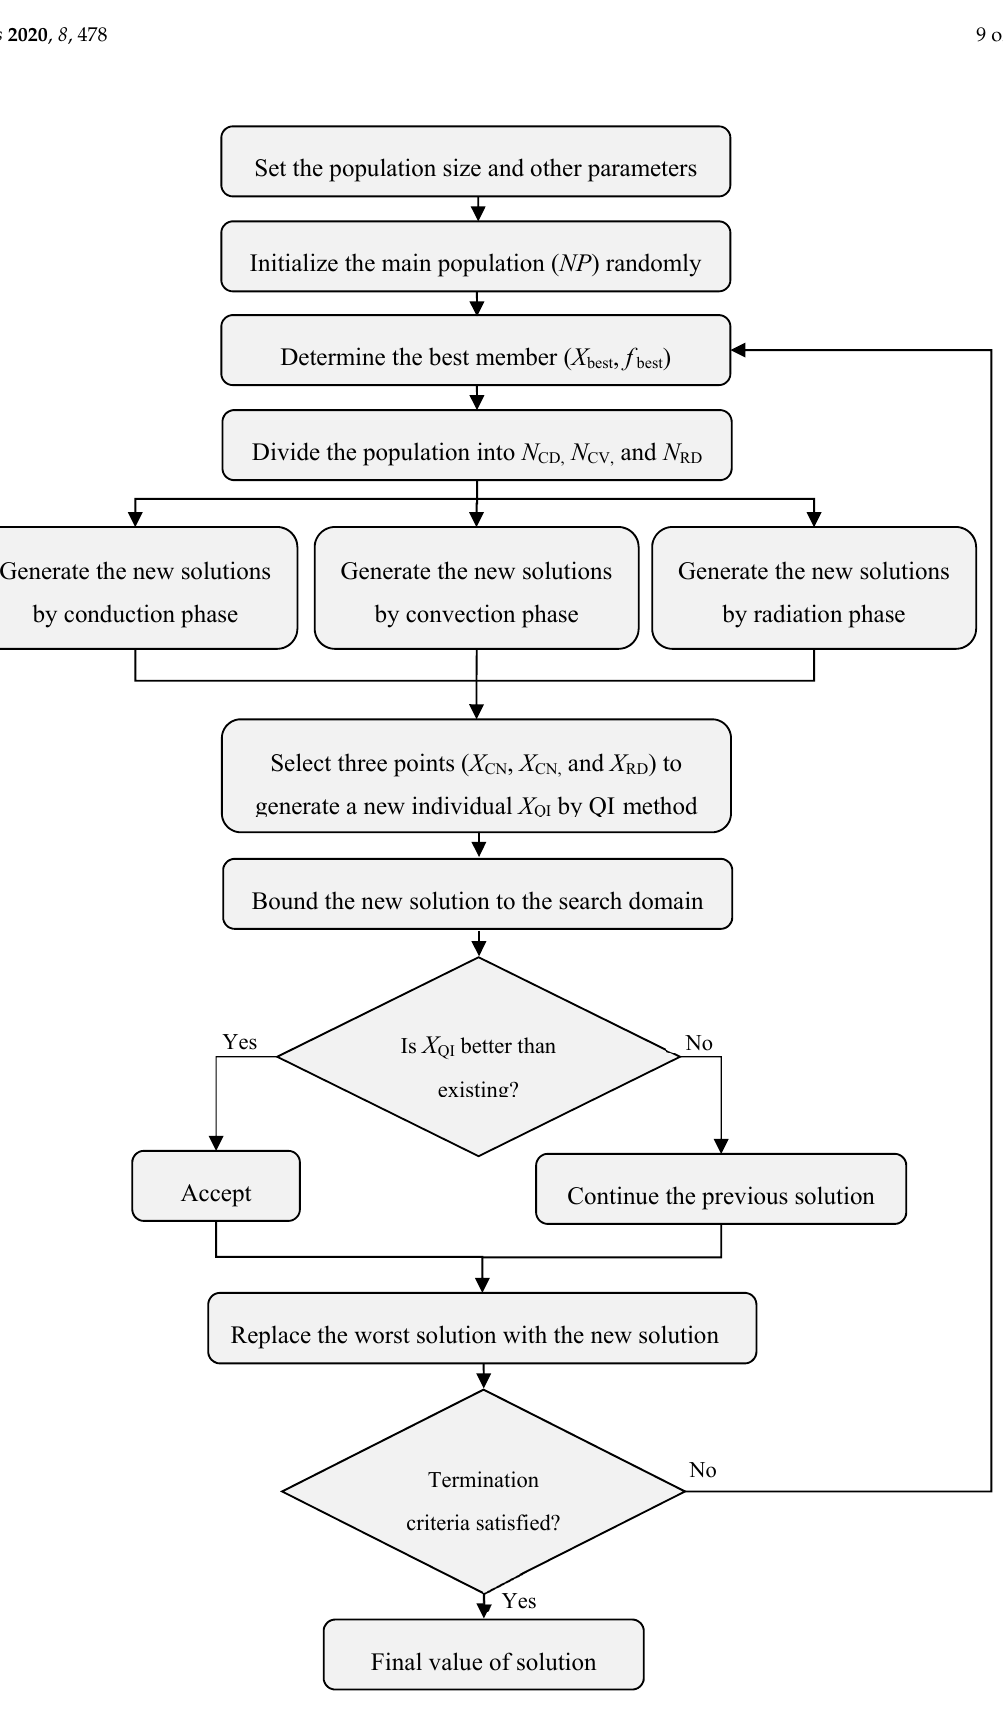
Figure 2. Flowchart of the quadratic interpolation based simultaneous heat transfer search (QISHTS) algorithm.